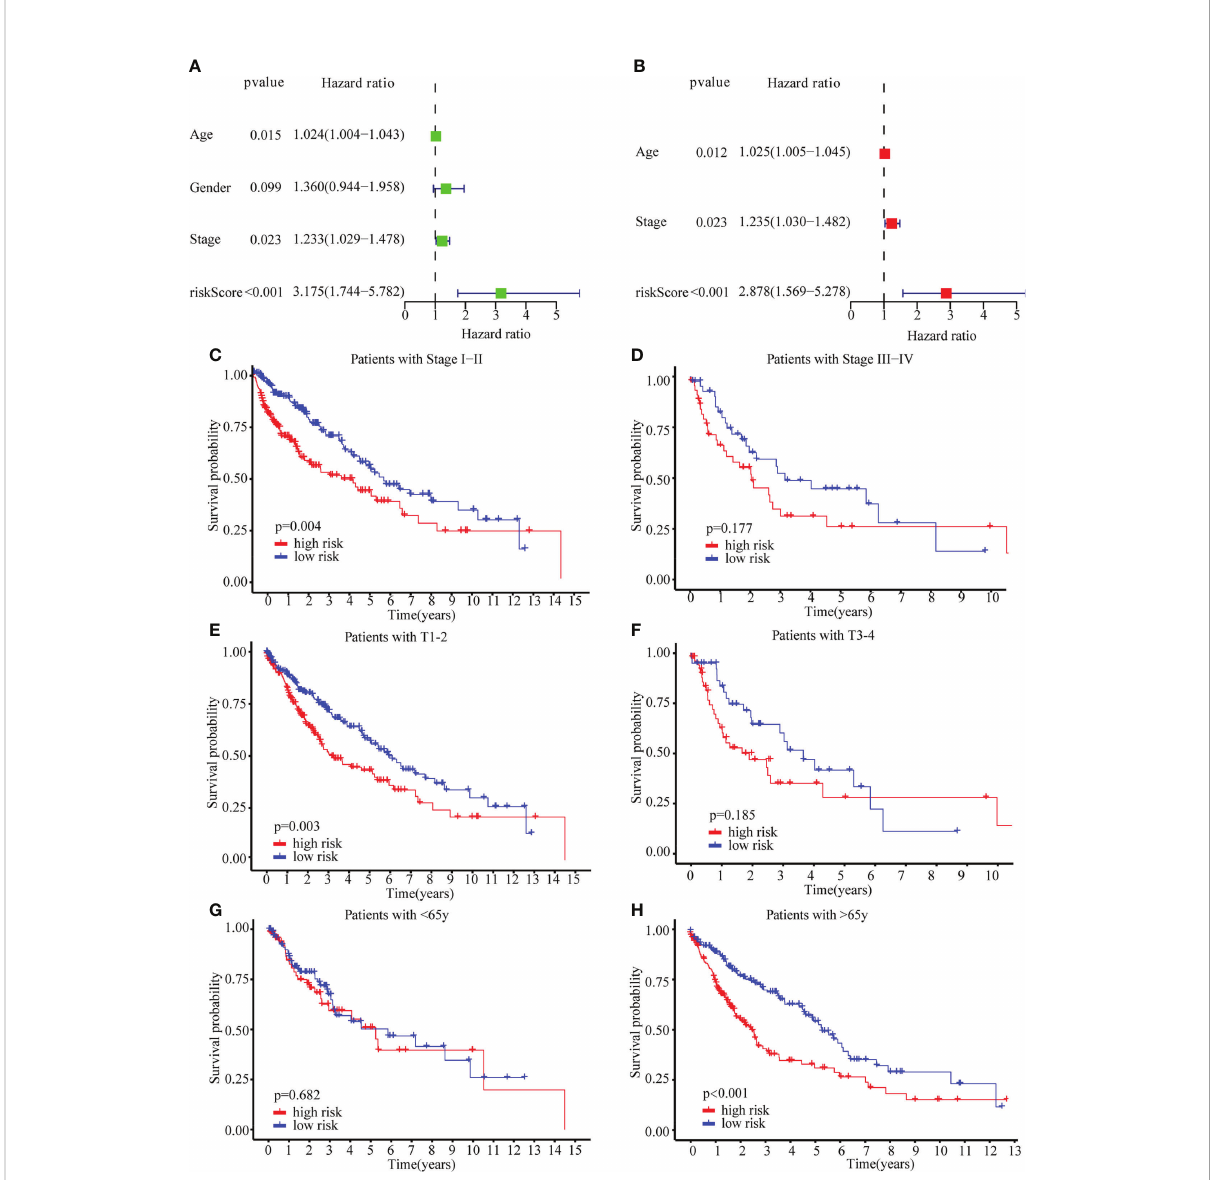
FIGURE 5 Univariate Cox regression, Multivariate Cox regression and strati fi ed analysis. (A) Univariate Cox regression in TCGA cohort. (B) Multivariate Cox regression in TCGA cohort. (C – H) strati fi ed analysis by clinical stage (I – II/III – IV) (C, D) , T stage (T1 – 2/T3 – 4) (E, F) , age ( ≤ 65/> 65) (G, H)